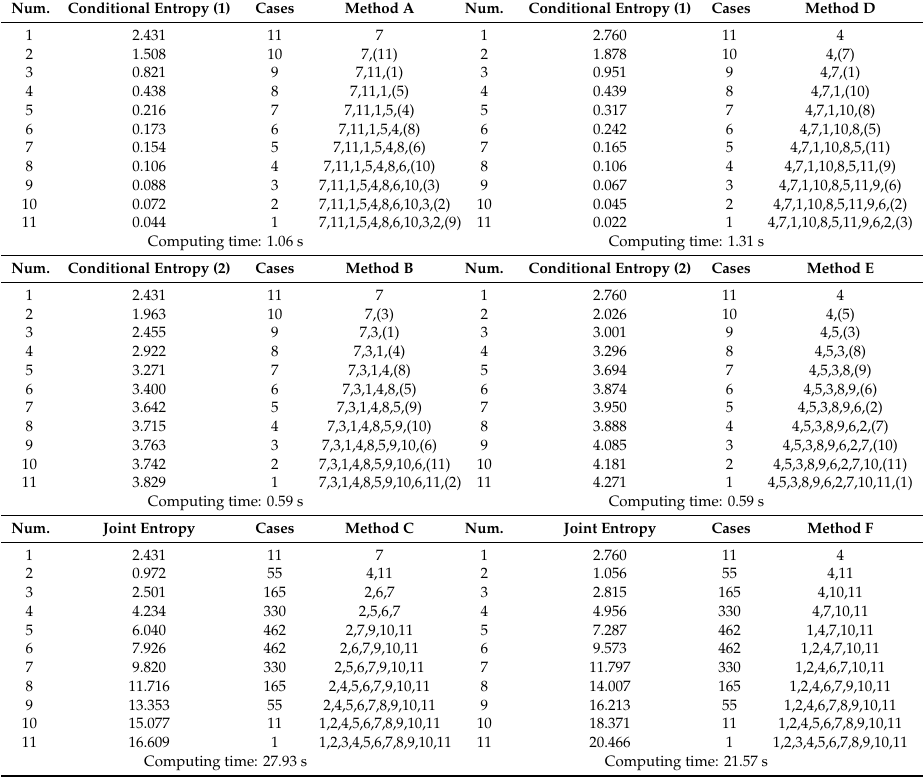
Table A2. Results of a select optimal rain gauge network of methods (shrink).